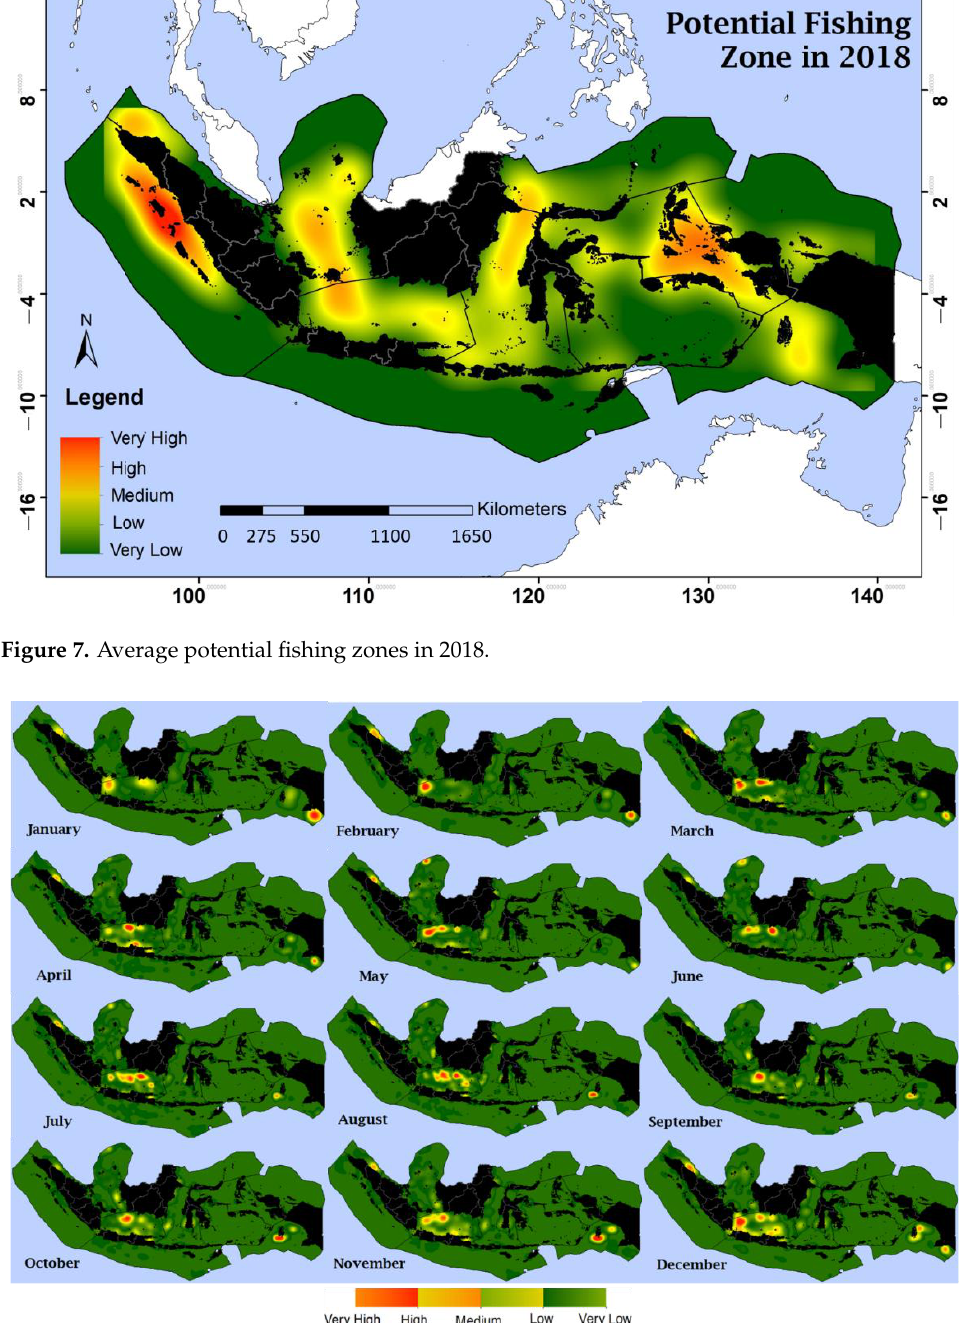
Figure 8. Monthly vessel activity zones in 2018.